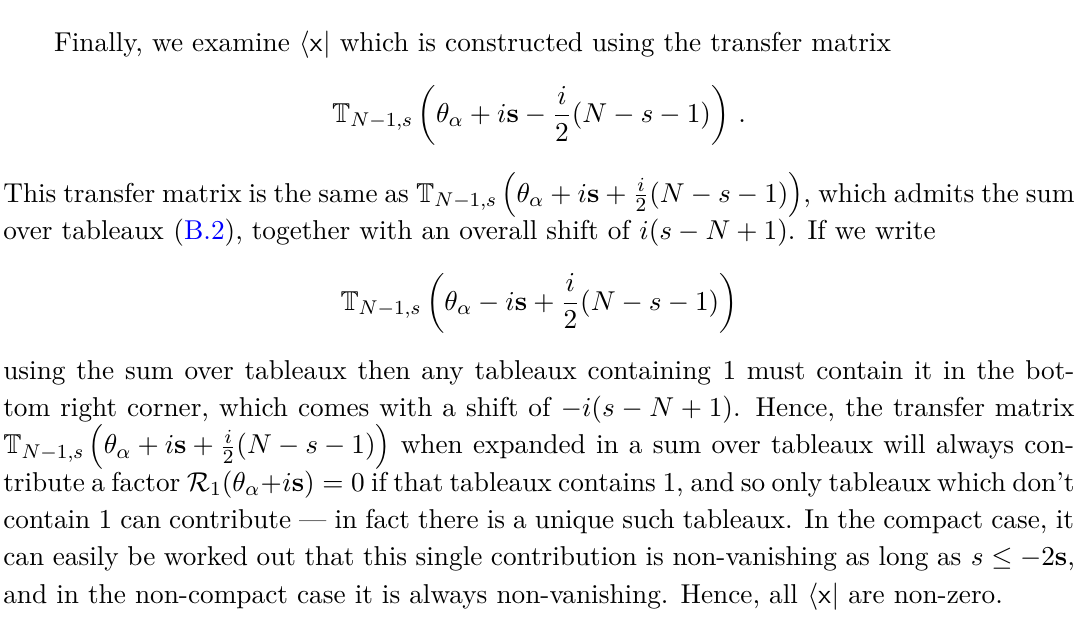
Figure 5 . The reduced Young diagram ¯ ν ∗ is denoted by the dotted exterior and the shaded region denotes the Young diagram µ